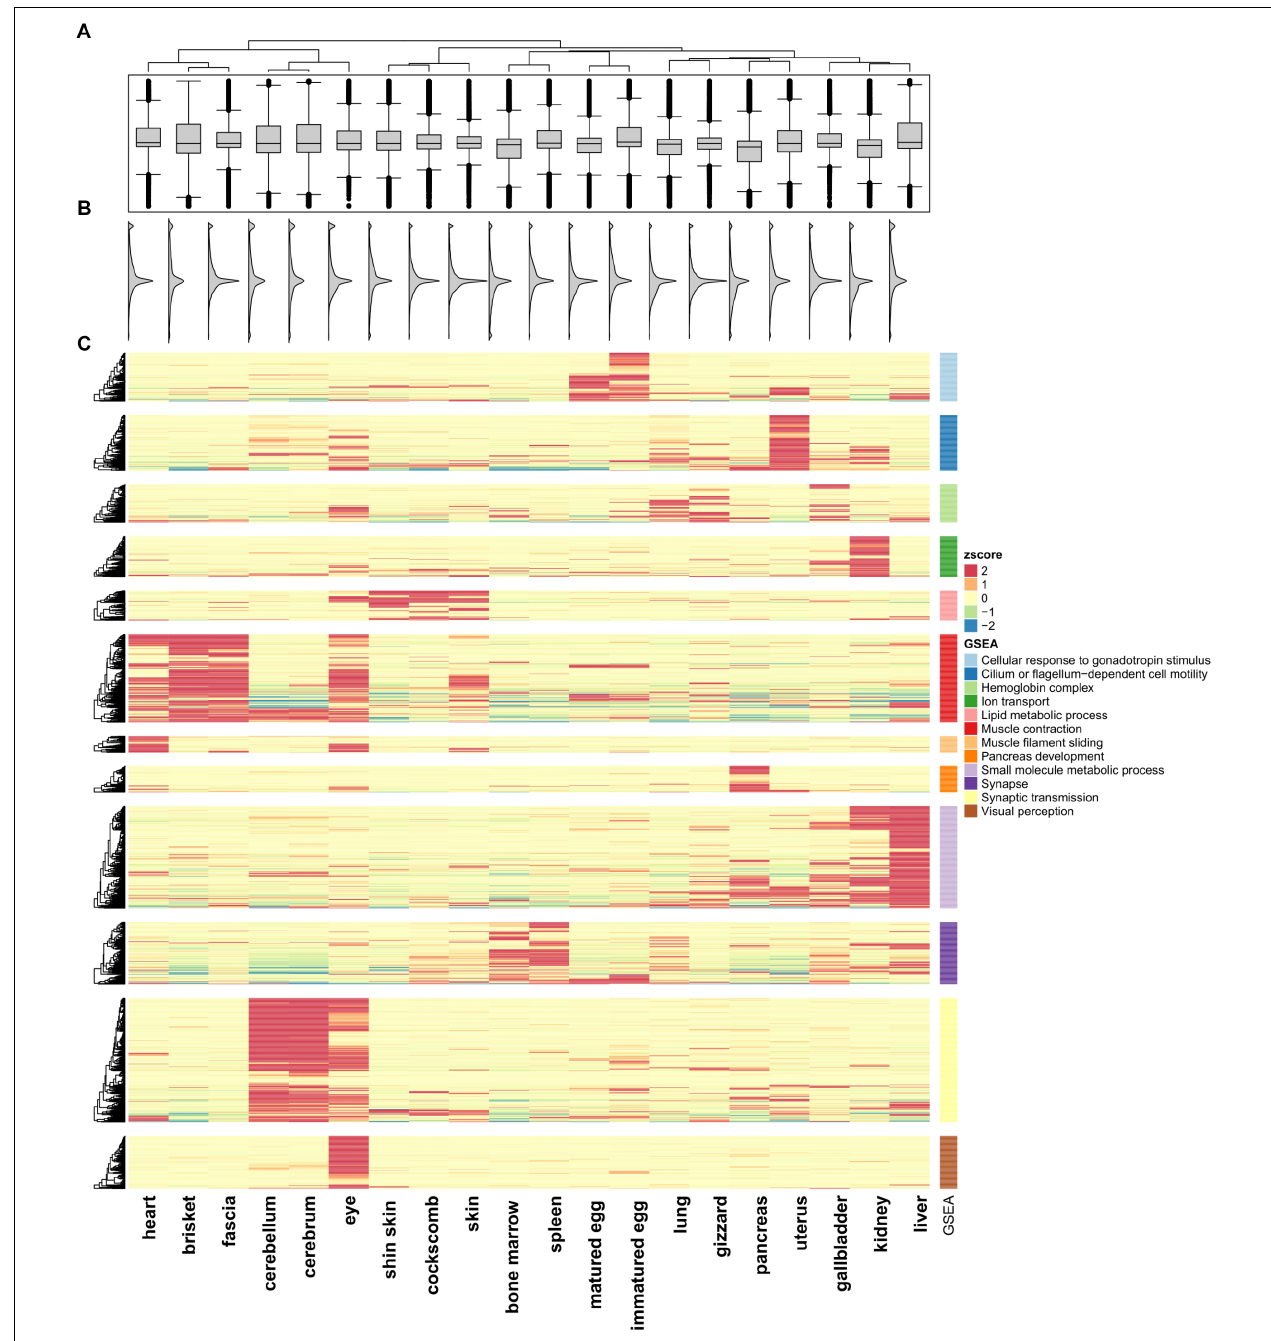
FIGURE 1 | Unsupervised K-means clustering of TSGs. (A) Gene expression differences in the 20 tissues. (B) Smoothed histogram of gene expression values. (C) Heatmap of tissue-specific genes using k-means clustering ( k = 12; Euclidian distance method; ward linkage method). FPKM values in each of the tissues were converted to z -scores. The GO terms for each cluster used the term with the highest enrichment score. The cluster names are labeled 1–12 from top to